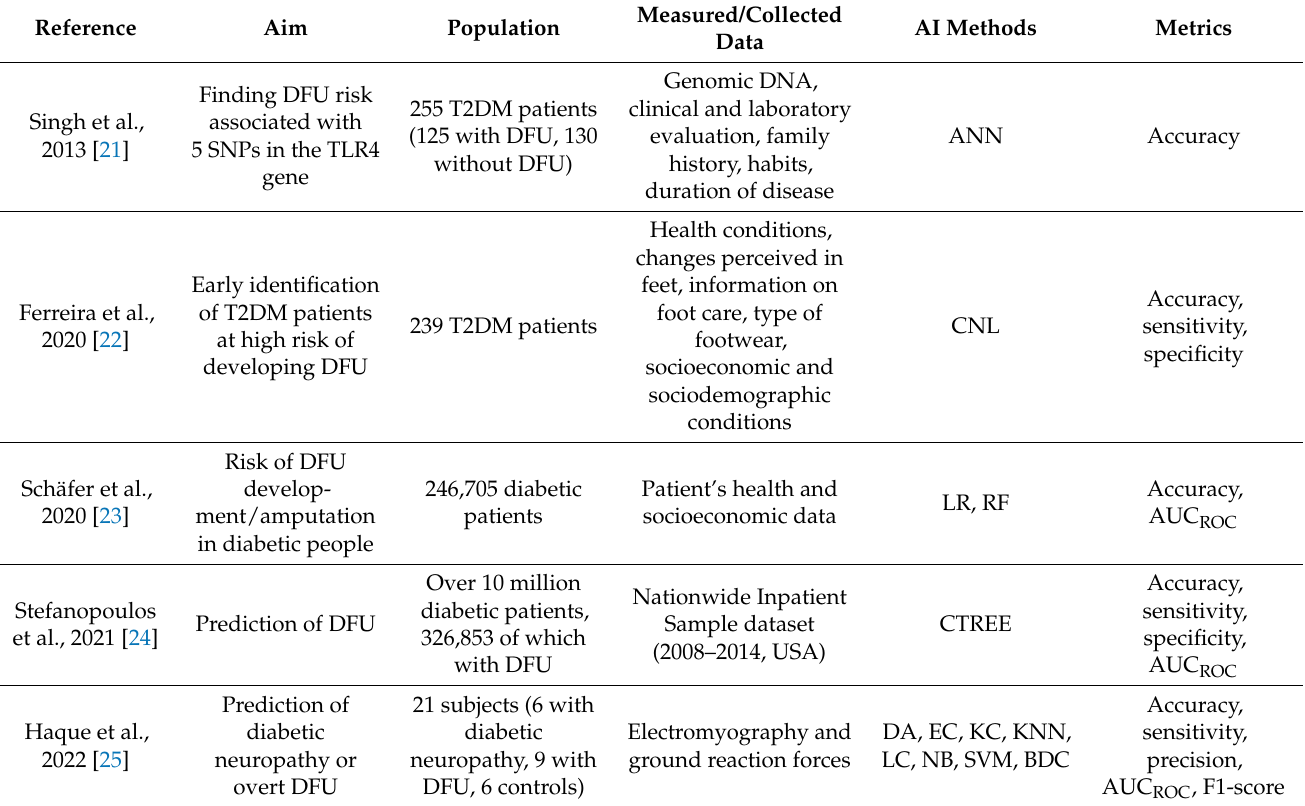
Table 1. Summary information related to the studies concerning diabetic foot syndrome screening— studies based on socioeconomic and sociodemographic data, and on different measured clinical data, but without imaging. The list of abbreviations is reported in the Abbreviations